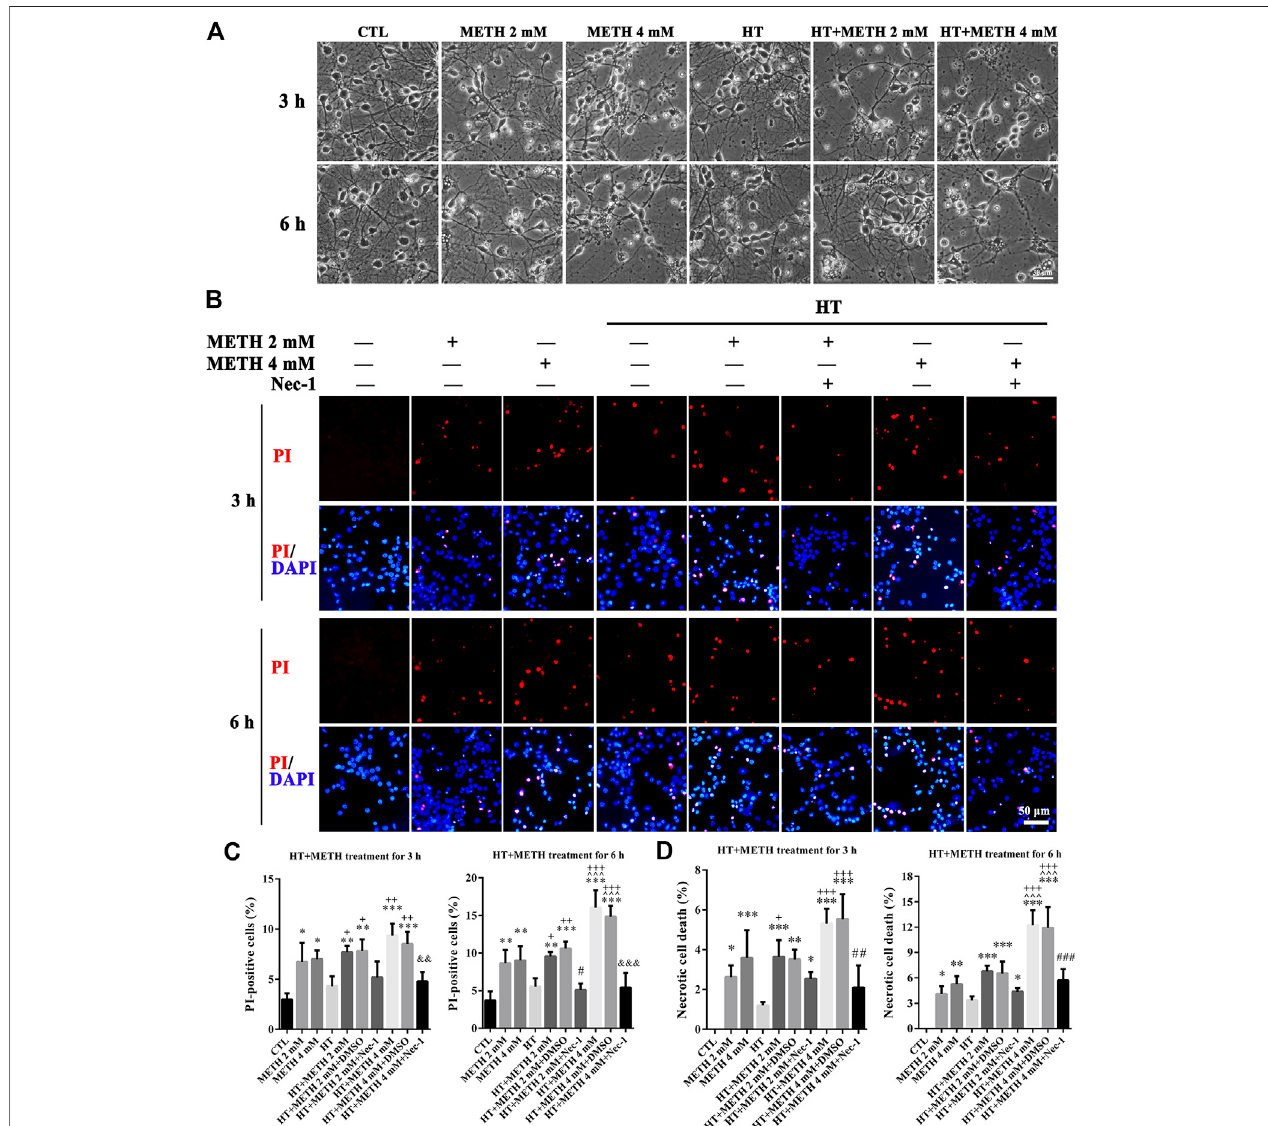
FIGURE2| METH/HT-inducedcellmorphologicalchangesandNec-1pre-treatmentattenuatedtheMETH/HT-inducednecrosisinstriatalneurons. (A) Cellmorphological changesofstriatalneuronstreatedwithMETHfor3and6 hunderalightmicroscope. Scalebar (cid:2) 30 μ m (B) PI(red)/DAPI(blue)doublestainingofstriatalneuronspre-treatedwith Nec-1after3and6 hofMETH/HT. Scalebar (cid:2) 50 μ m. (C) StatisticalanalysisofthePI/DAPIdoublestainingofnecroticcells.Datawereanalyzedbyone-wayANOVA,followedby aTukeymultiplecomparisonsposttest( n (cid:2) 3).* p < 0.05,** p < 0.01,*** p < 0.001vs.CTLgroup; ^^^ p < 0.05vs.METH4 mM;+ p < 0.05,++ p < 0.01,+++ p < 0.001vs.HT; # p < 0.05vs.HT+METH2 mMgroup;&& p < 0.01,&&& p < 0.001vs.HT+METH4 mMgroup. (D) ThepercentageofnecroticneurondeathafterMETH/HTtreatmentandpre- treatmentwith Nec-1wasdetermined with LDHreleaseassays. Datawereanalyzedbyone-way ANOVA,followedbyaTukey multiplecomparisonsposttest( n (cid:2) 3). * p < 0.05, ** p < 0.01, *** p < 0.001 vs. CTL group; ^^^ p < 0.05 vs. METH 4 mM; + p < 0.05, +++ p < 0.001 vs. HT; ## p < 0.01, ### p < 0.001 vs. HT + METH 4 mM group.